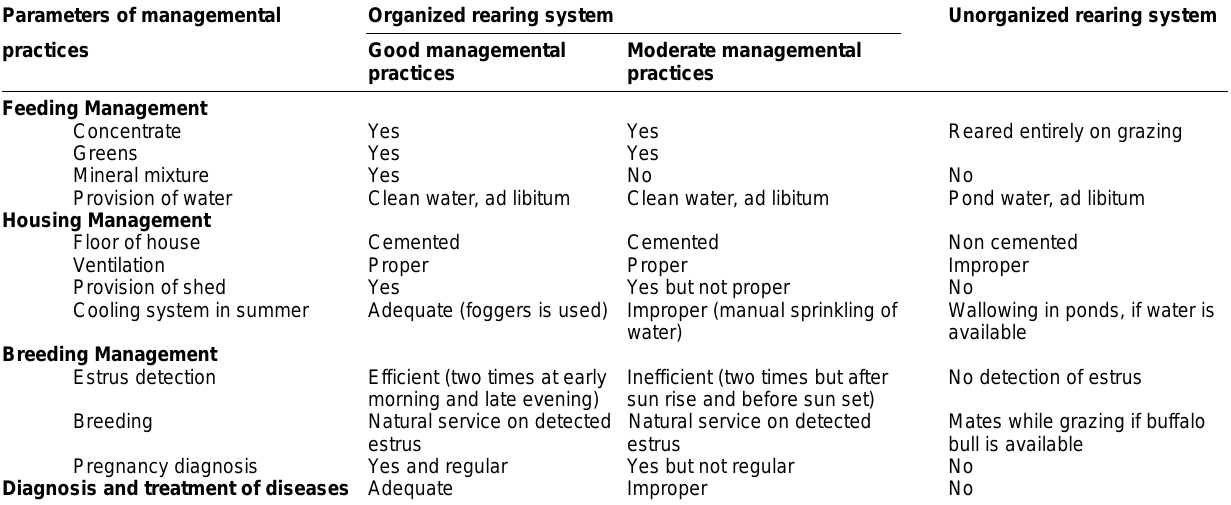
Table-1. Different managemental